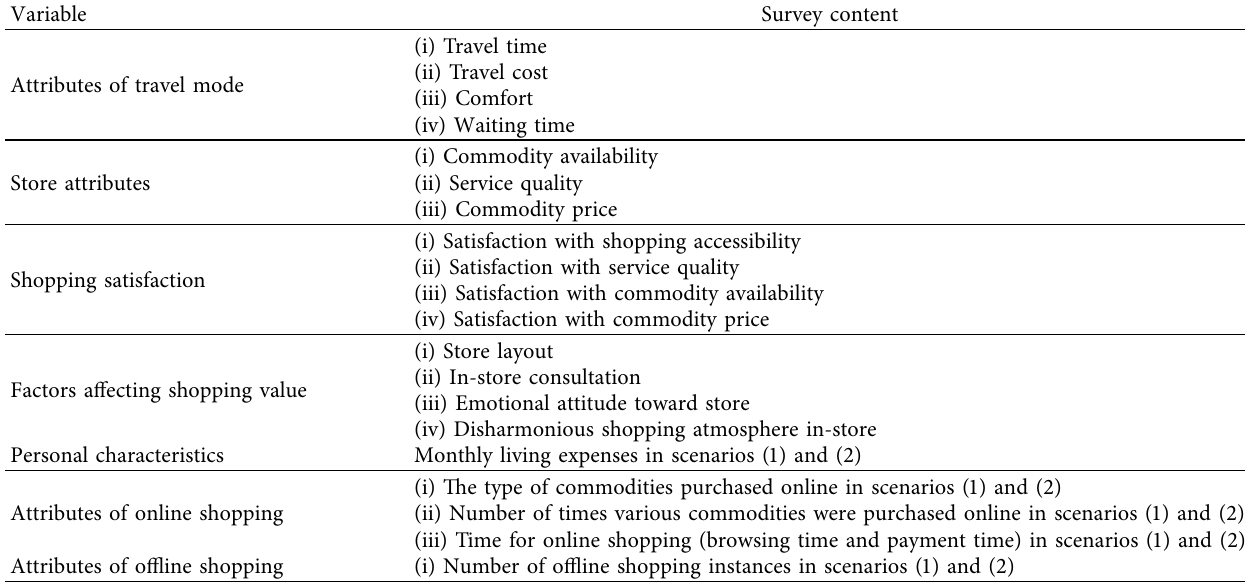
Table 2: Main survey contents.